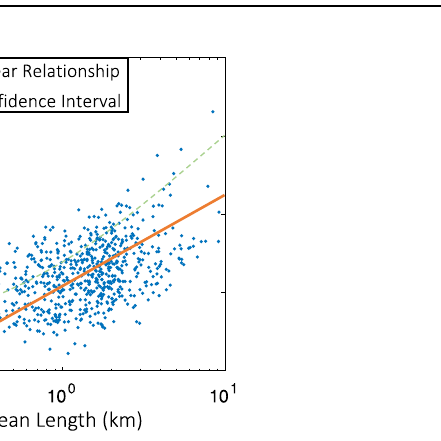
100 events. b Percentage of residents experiencing a longer-than-5-day power outage averaged over all synthetic storms simulated for the historical climate vs. harmonic mean length (reciprocal of the arithmetic mean of reciprocals) of power distribution network sectors for each census tract in Harris County. The red line shows the linear fi t; dashed curves show the ±1 σ uncertainty